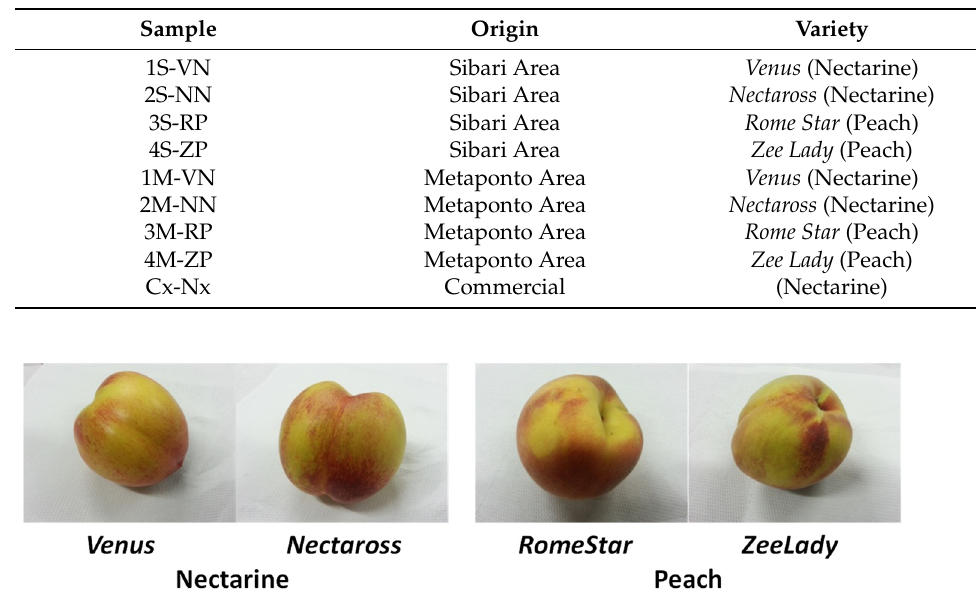
Table 6. Geographical origin and variety of samples analyzed in the present study.